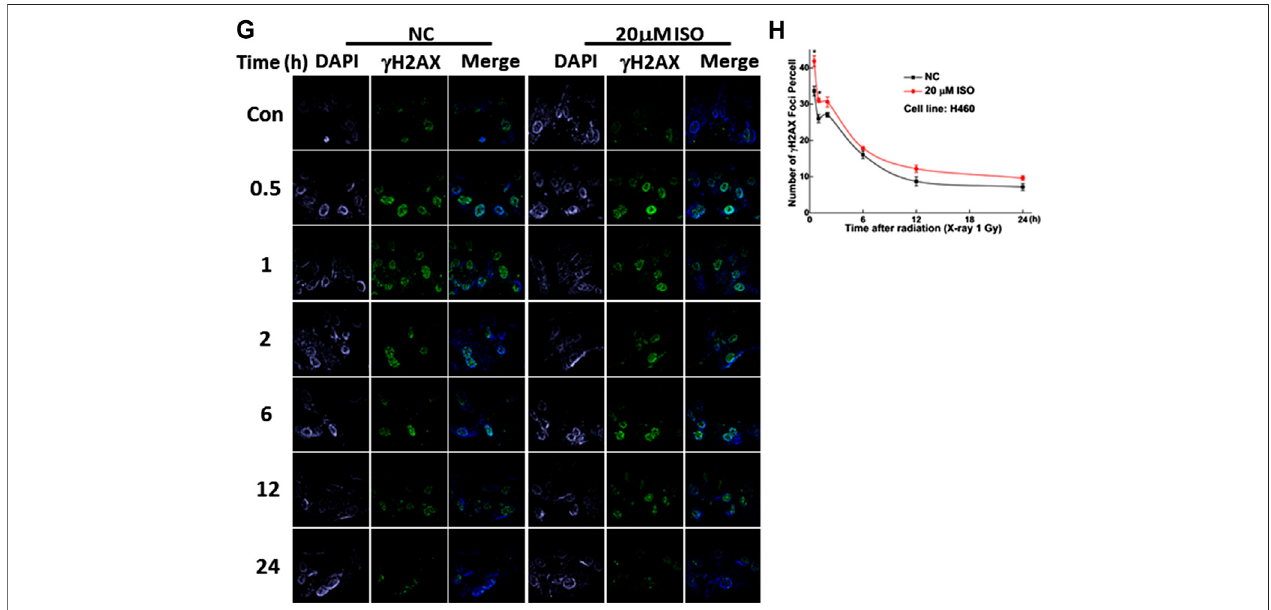
( Figure 3F ), indicating that ISO and irradiation accelerated the decrease of the of Bcl2/Bax ratio. Taken collectively, these results indicated that ISO treatment facilitated the apoptosis after